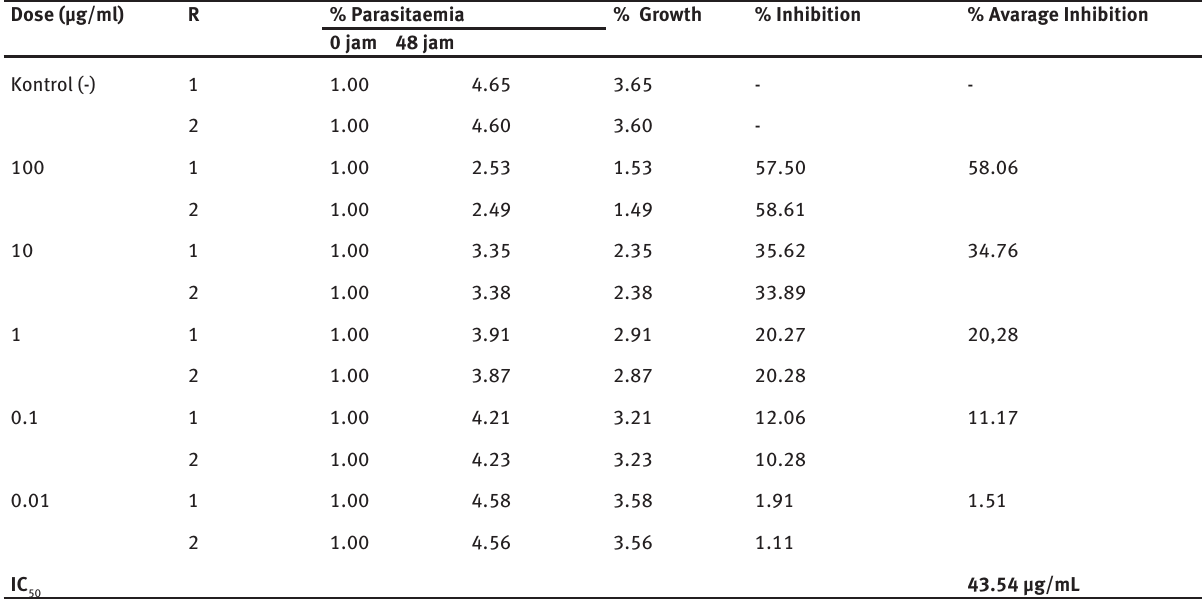
Table 3: Antimalarial activity of sistigmast-4-en-3-one against P. falciparum 3D7. Dose (µg/ml)